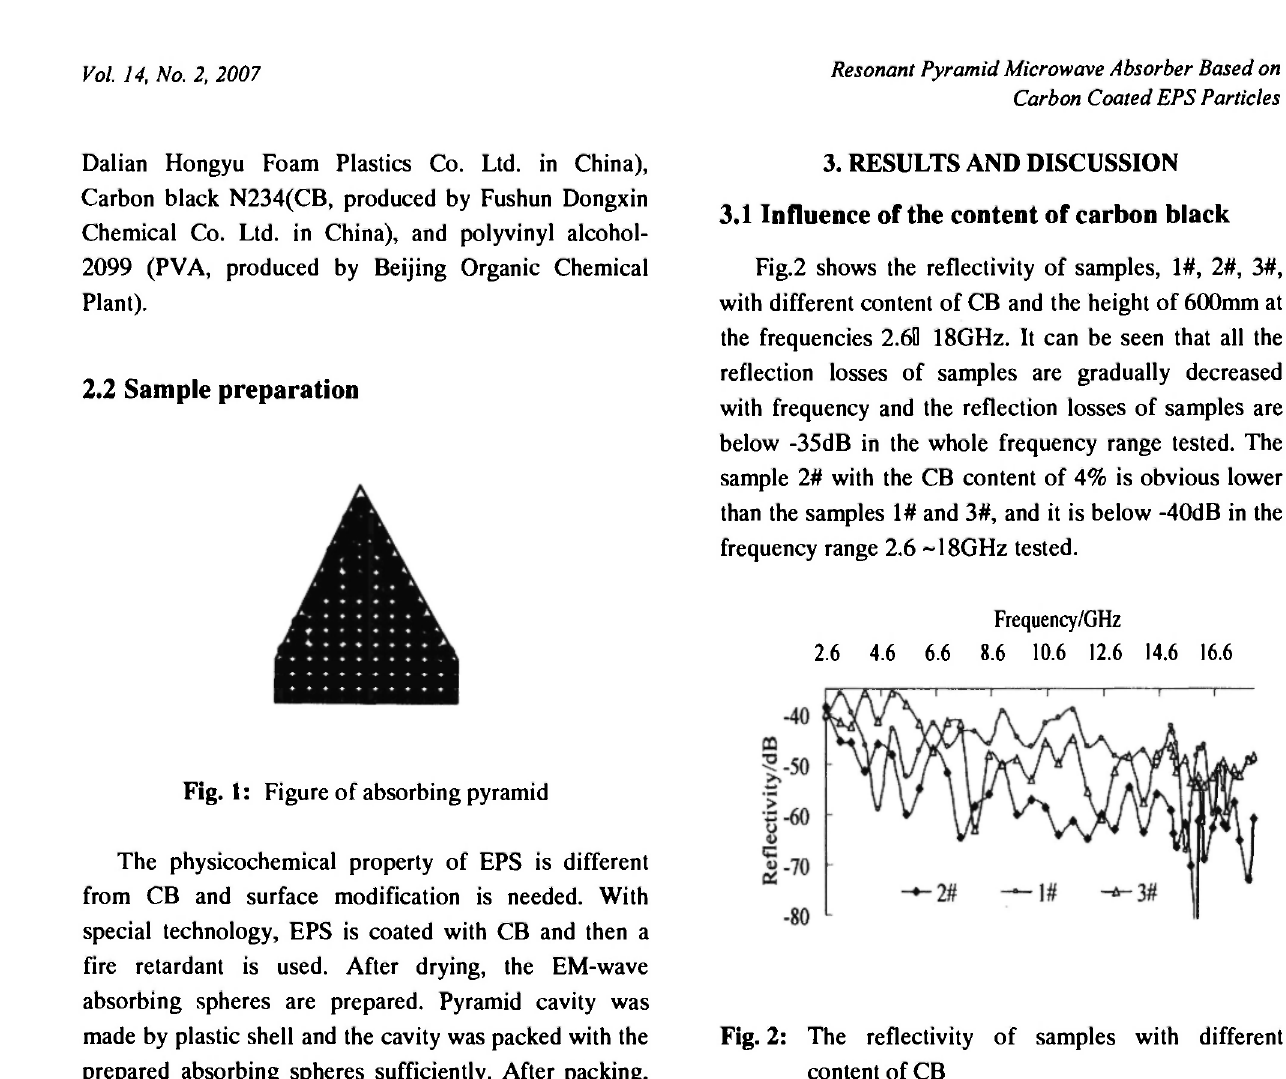
Fig. 2: The reflectivity of samples with different content of